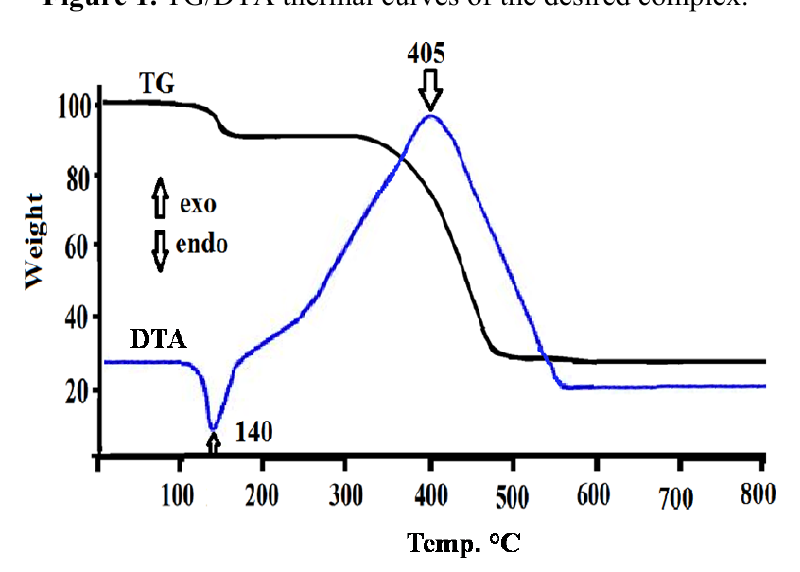
Figure 1. TG/DTA thermal curves of the desired